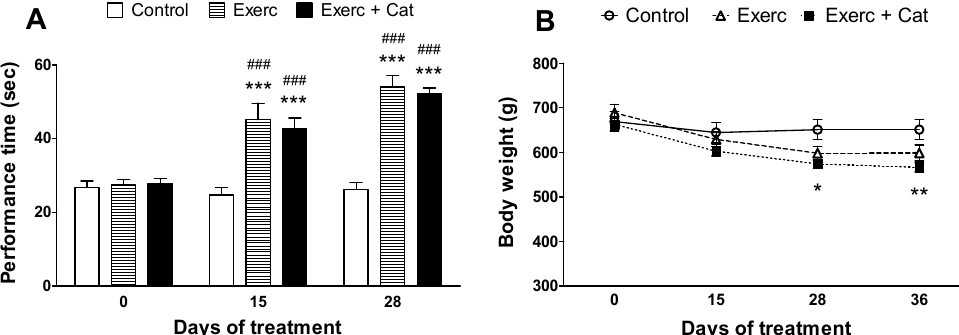
Figure 1. Effect of exercise and the combined action of exercise and catechin treatment on motor coordination ( A ) and the evolution of body weight ( B ) in old rats (18 months). ( A ) Bars represent the mean ± SEM of the time spent (sec) on the rotating wheel, using the rotarod test, of animals subjected to a daily physical exercise program (Exerc, n = 7) and animals subjected to the combined effect of a daily physical exercise program and intraperitoneal administration of catechin (20 mg/kg/day, n = 7; Exerc + Cat,) compared to control animals ( n = 7). Two-way repeated measures ANOVA detected a significant effect for the treatment (F(2,54) = 19.6, p < 0.0001), the subjects (F(18,54) = 4.6, p < 0.0001), the age (F(2,54) = 78, p < 0.0001) and the interaction (F(4,54) = 21.90, p < 0.0001). B) Dots represent the mean ± SEM of the body weight (g) of the same animals. Two-way repeated measures ANOVA detected a significant effect for the subjects (F(18,72) = 33.12, p < 0.0001), the age (F(3,72) = 88.50, p < 0.0001) and the interaction (F(6,72) = 12.46, p < 0.0001), but not for the treatment (F(2,72) = 2.451, p = 0.1145). * p < 0.05, ** p < 0.01, *** p < 0.001 when compared to the control group; ### p < 0.001 comparing the values obtained by each group before and after performing the treatments (two-way ANOVA followed by Bonferroni).